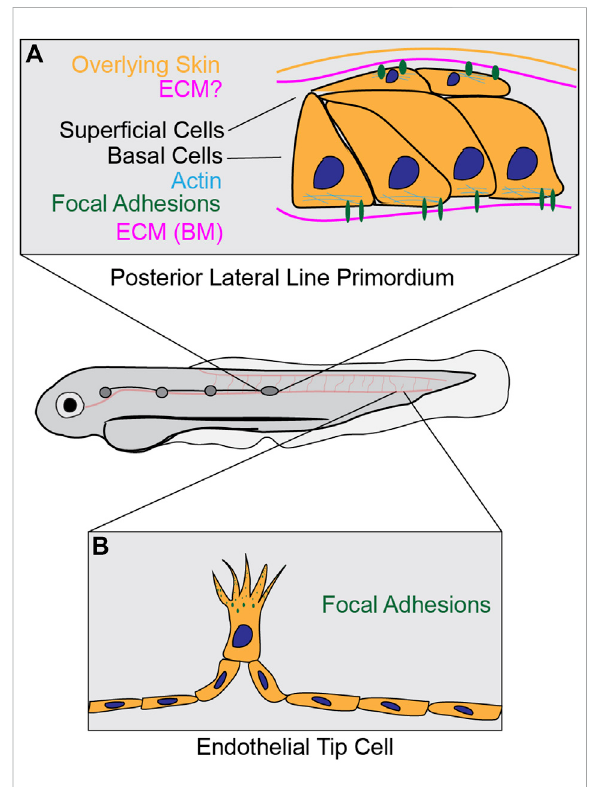
FIGURE 4 Focal adhesions in zebra fi sh collective cell migration. (A) DuringpLLprimordiummigration, basalcellsformfocaladhesions at contact sites with the ECM at the basement membrane. Additionally, it has been shown that super fi cial cells form focal adhesions at the apical surface, although it is unknown if there is an ECM layer (question mark) in between super fi cial cells and the overlying skin. For a live timelapse imaging example of